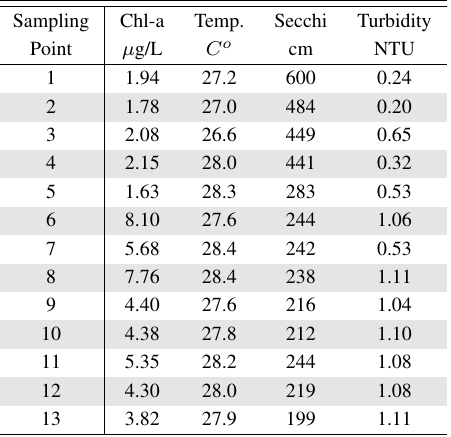
Table 2. Values obtained for the four optically active component parameters.